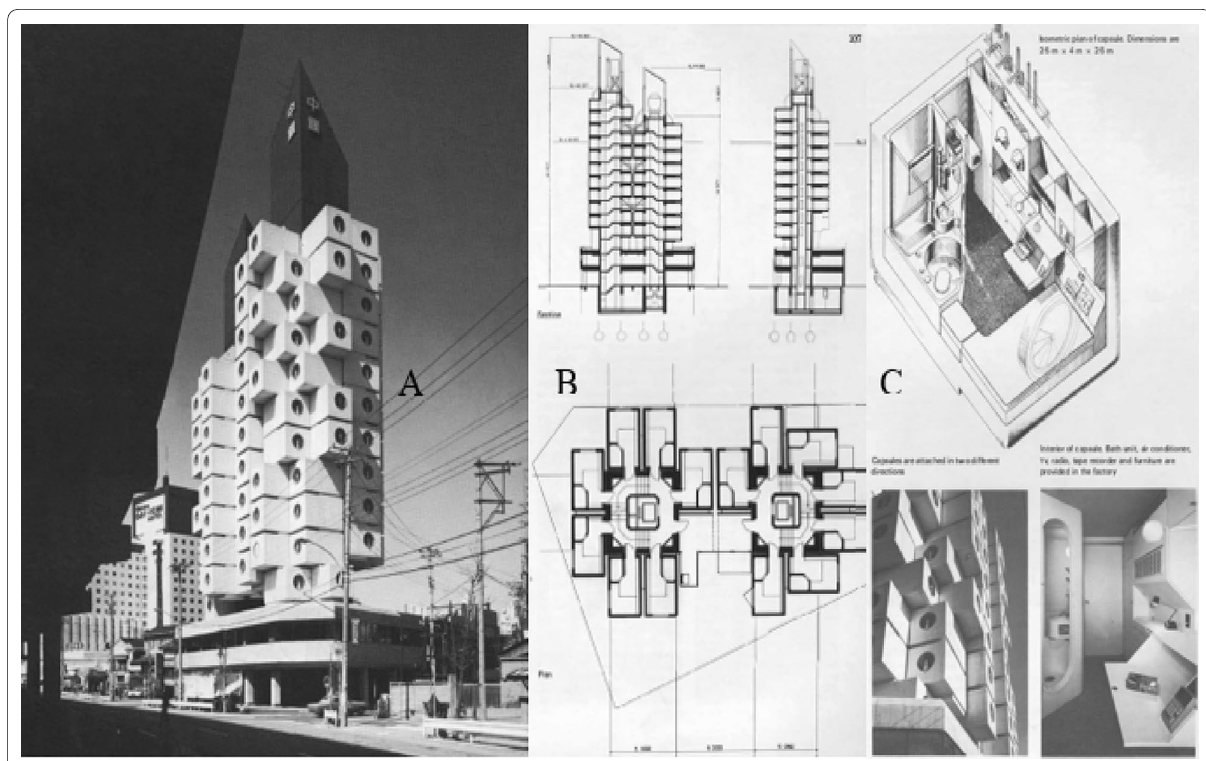
Fig. 1 Nakagin Capsule Apartment, Tokyo, Japan ( Source: Metabolism in architecture (Kurokawa